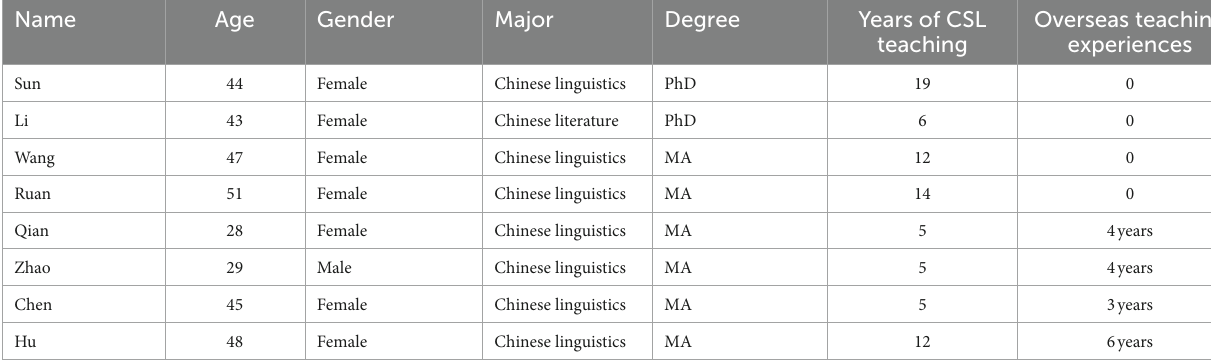
TABLE 1 The teacher interviewees’